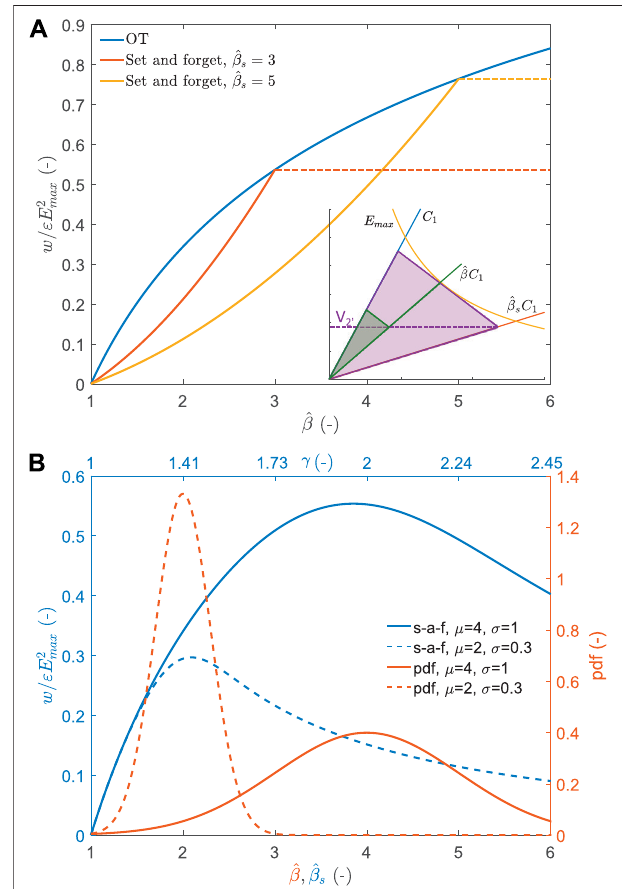
FIGURE 6 | (A) normalised energy density harvested as a function of capacitance swing ^ β using the set-and forget strategy. Two different arbitrary set points are shown: a circuit optimised for ^ β s (cid:1) 3 (red) and one for ^ β s (cid:1) 5 (yellow). The energy density of the OT cycle is shown in blue as a comparison. inset: representation of the set-and-forget cycle on the Q-V plane. The circuit is optimised for the purple cycle, but a smaller amplitude leads to the green triangle. (B) Red: probability density function (pdf) for two normal distributions of capacitance swing. Blue: average energy harvested per cycle for the same distribution of capacitance swing, as a function circuit set point ^ β s